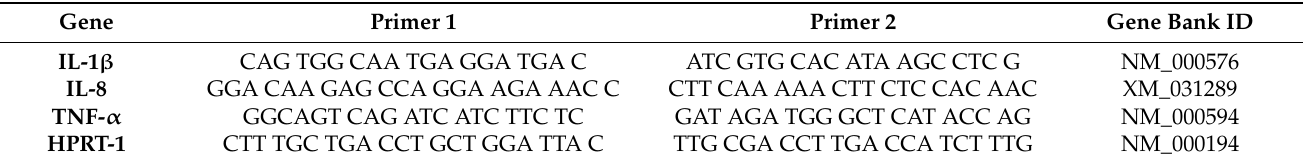
Table 3. List of primers for qRT-PCR.